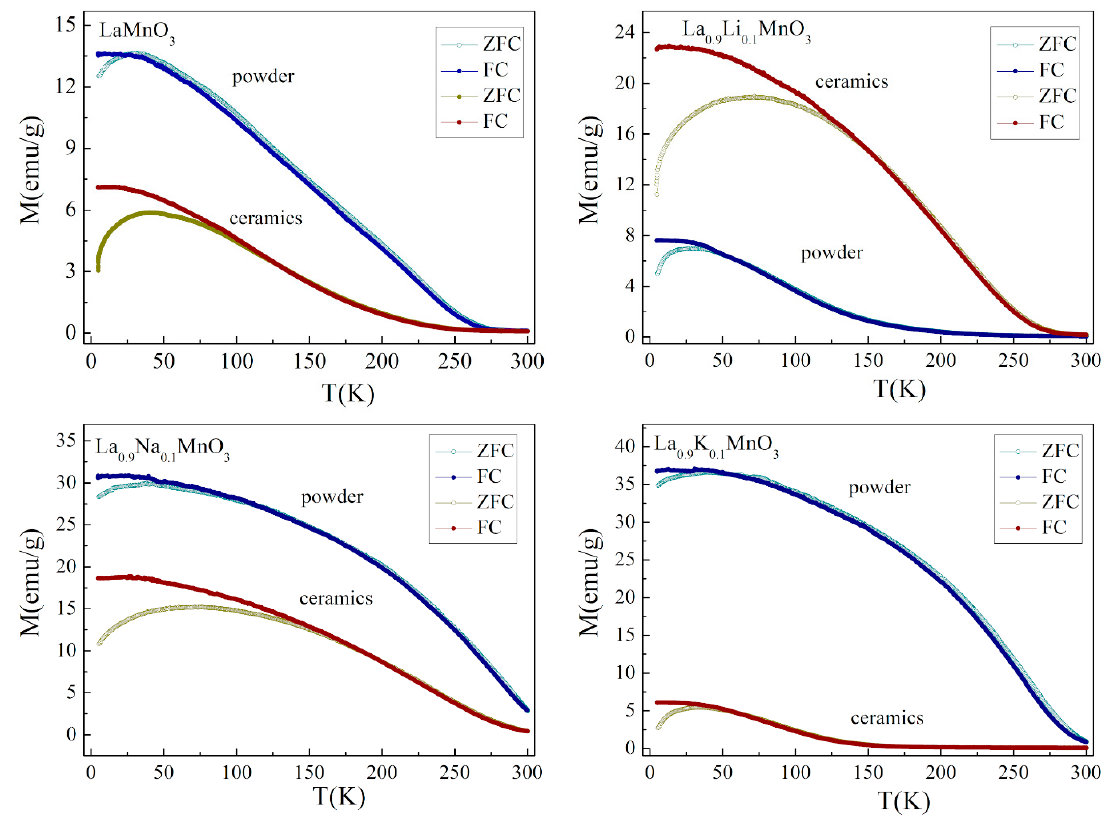
Figure 7. Field cooled and zero-field cooled dependencies of magnetization recorded for the La 0.9 A 0.1 MnO 3 compounds (A = Na, Li, K) and initial compound LaMnO 3 in a magnetic field of 1kOe.